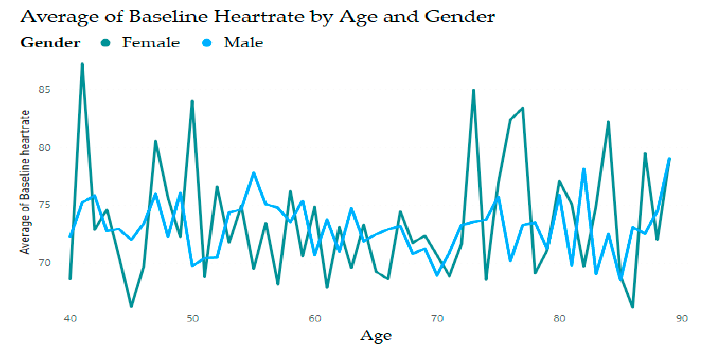
Figure 2. Heart rates by age and gender.